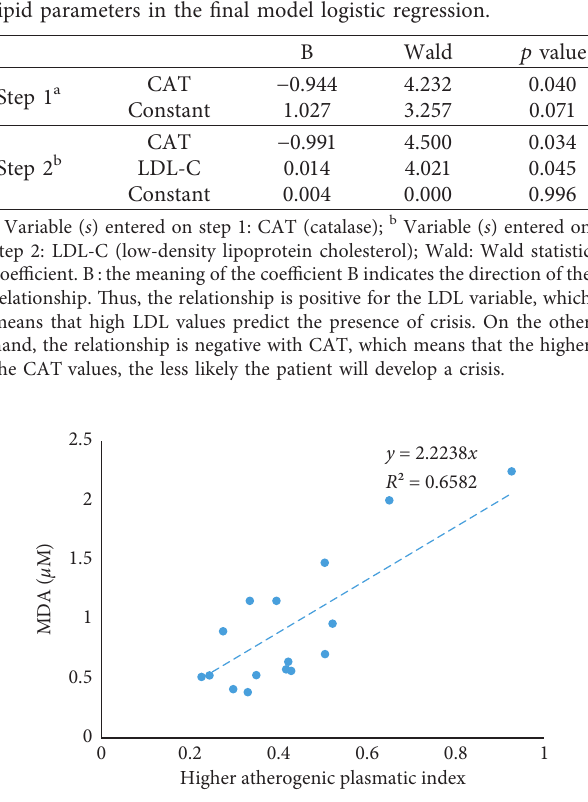
Figure 1: Linear regression between the MDA level and the high API.